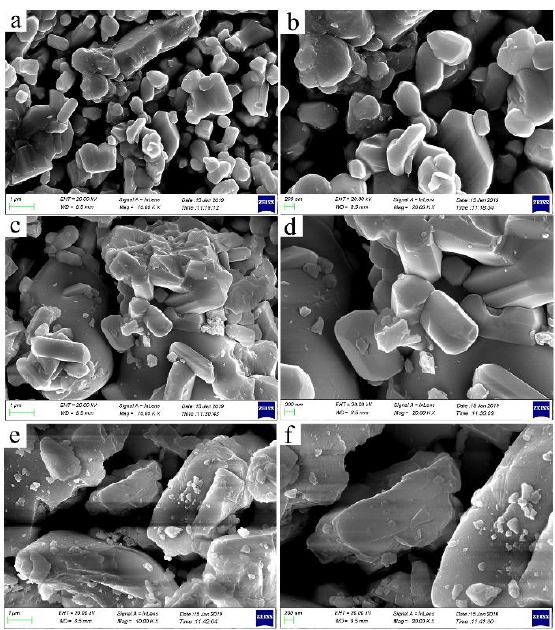
Figure 2. Field emission scanning electronic micrograph (FE-SEM) pictures of Sm 3+ doped Lu 2 Mo 0.5 W 0.5 O 6 ( a , b ), Lu 2 MoWO 9 ( c , d ), and Lu 2 (Mo 0.5 W 0.5 O 4 ) 3 ( e , f